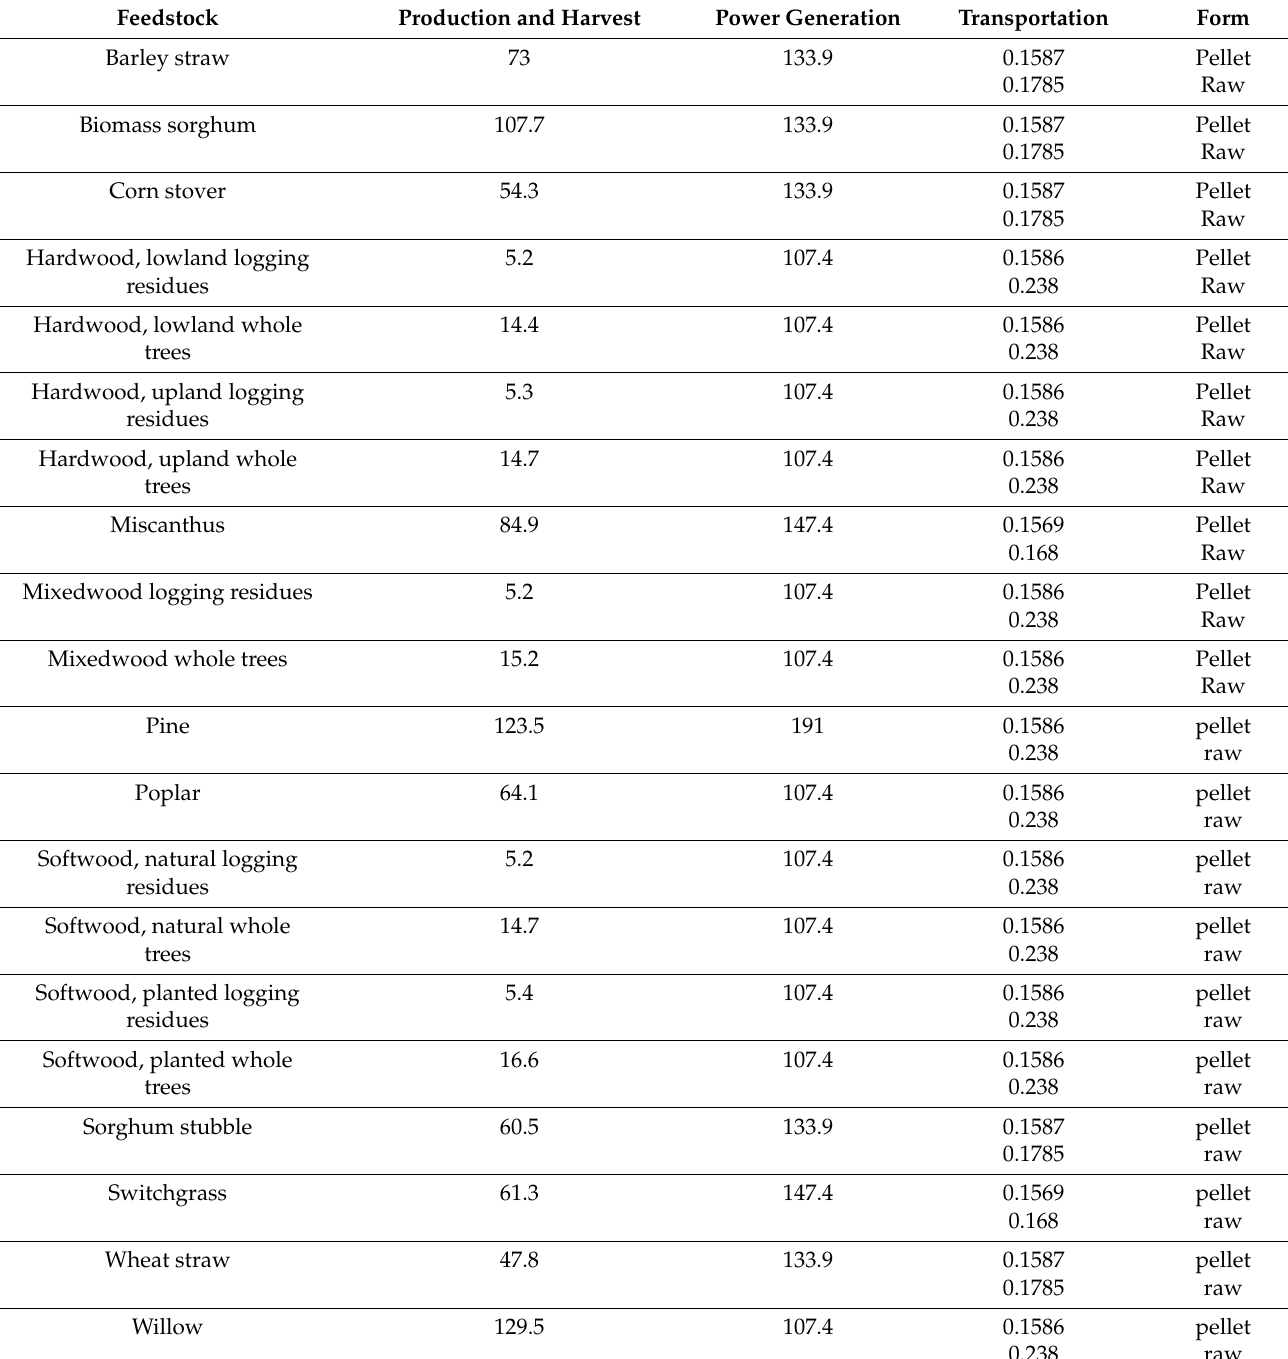
Table A8. Carbon emissions associated with production, harvesting, and transportation of the different feedstocks used in this study. These results serve as an input for the BILT model